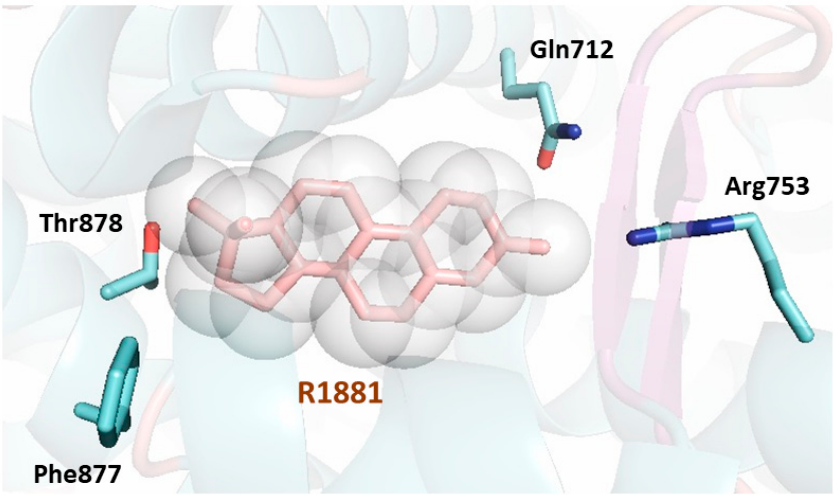
Figure 5. Cartoon representation of the first AR LBD crystal structure solved (PDB [Protein Data Bank] code 1E3G). [55] The AR LBD secondary structure is shown depicting the helices, loops, and β -sheets surrounding the ligand (shown as a stick model in pink surrounded by a sphere representation). The LBP of the AR LBD is formed by twenty residues lining the bound ligand. Three residues make hydrogen bonds with the ligand (Gln712, Arg753 and Thr878) and are shown as sticks in blue showing their lateral chains. The residue Phe877, also shown as a stick representation in blue, has been found to be linked to enzalutamide resistance. All the residues lining the pocket extracted from the PISA server (https://www.ebi.ac.uk/pdbe/pisa/) are: Leu702, Leu705, Asn706, Leu708, Gly709, Gln712, Trp742, Met743, Met746, Val747, Met750, Arg753, Phe765, Met781, Met788, Leu 874, Phe877, Leu881, Met896 and Ile900.